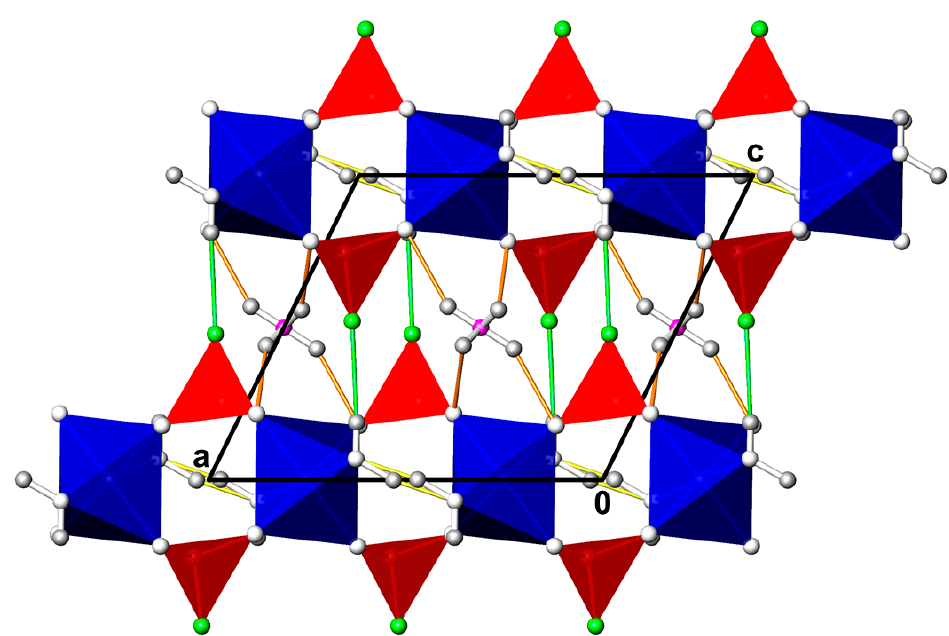
Figure 10. The crystal structure of NH 4 Cu 2 (H 3 O 2 )(PO 3 F) 2 in a projection along [010]. Colour code as in Figure 6.